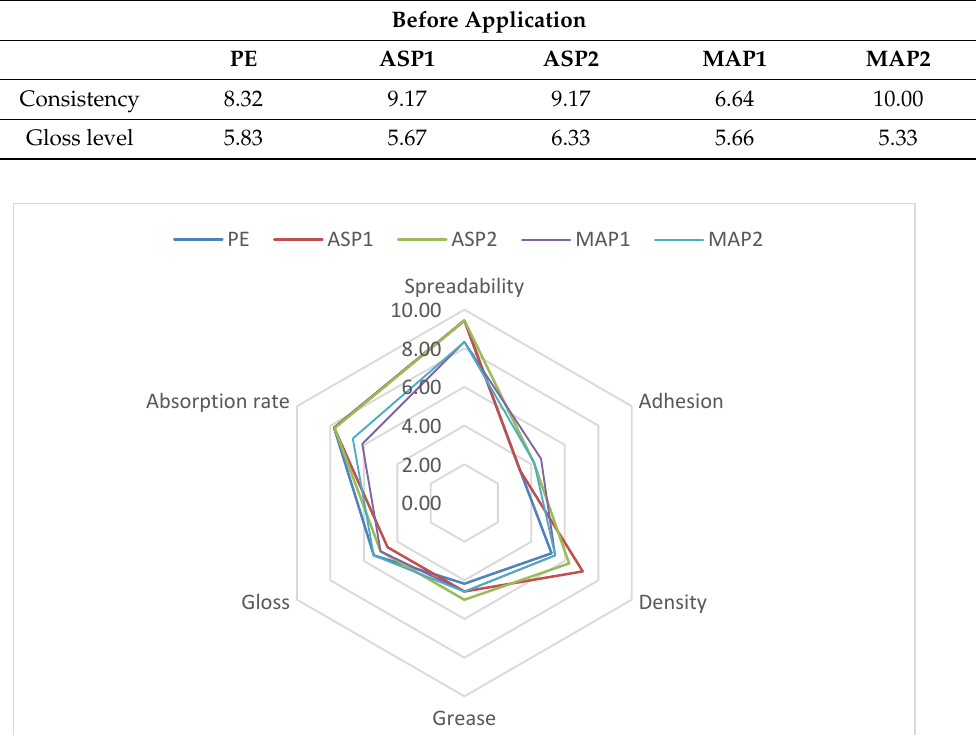
Table 5. The results of sensory analysis of the investigated samples before application converted to 1–10 scale.